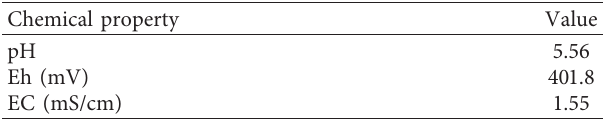
Table 6: Chemical property of AMD.